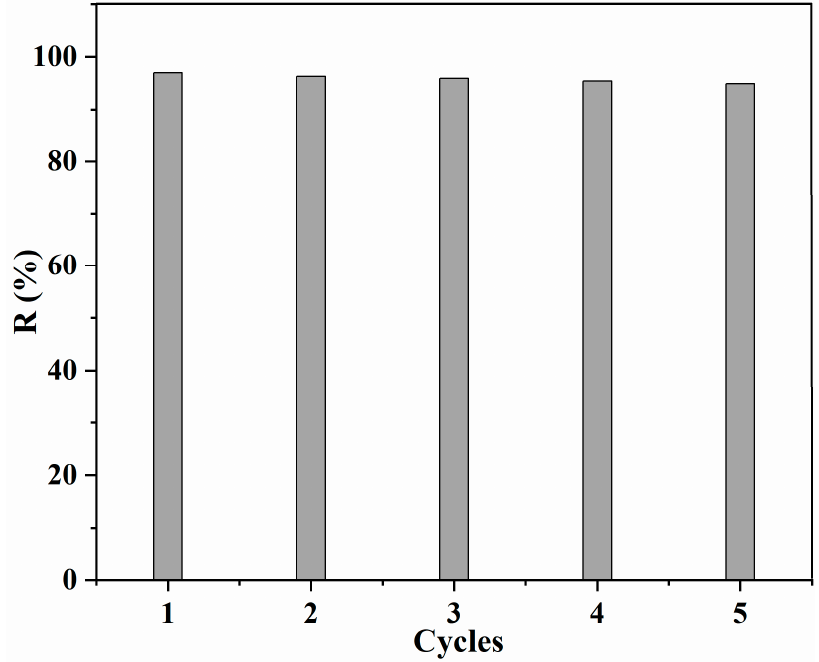
Figure 9. Effect of recycling times on the adsorption capacity Q (mg/g) with 40%Tan/SA beads ( m = 20 mg, C 0 = 10 mg/L, V = 30 mL, pH = 12, T = 45 °C, s = 150 r/min, t = 4 h). Table 3. Comparison of the MB removal performance with similar